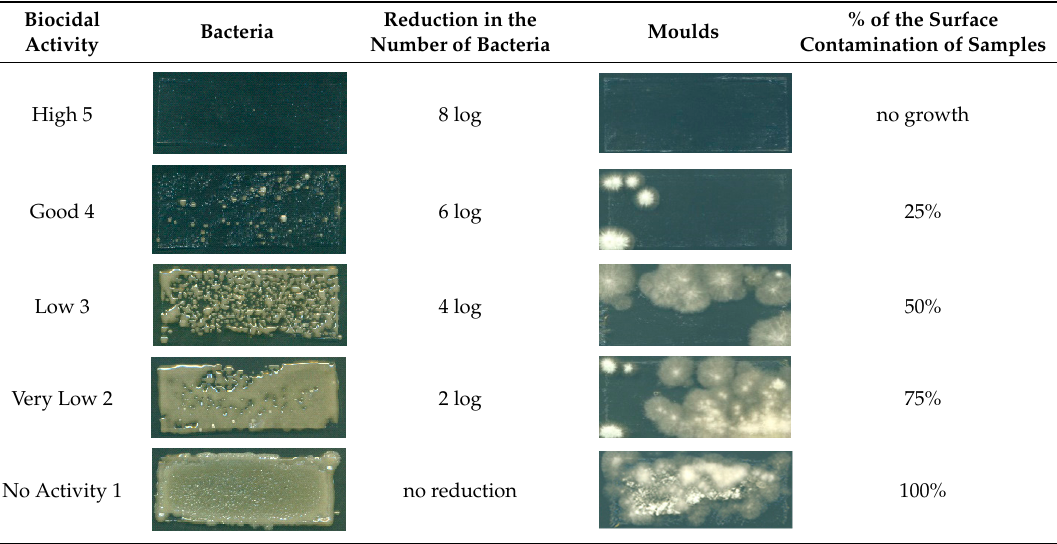
Table 6. The method of evaluating antimicrobial activity of biocides.